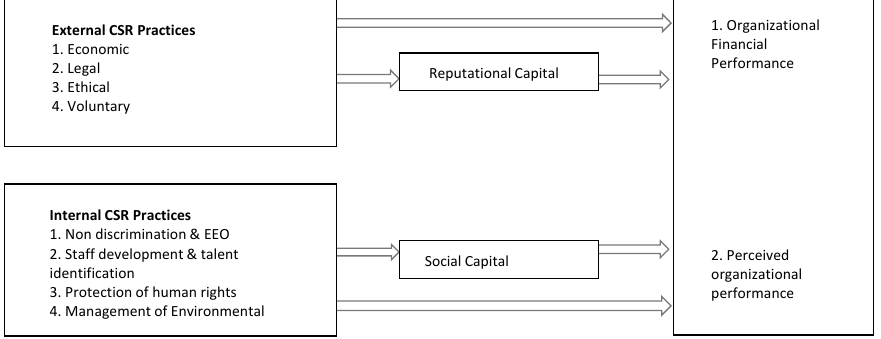
Fig. 1 – CSR as a source of competitive advantage through the creation of intangible resources in an organisation. Source: Saeed & Arshad,